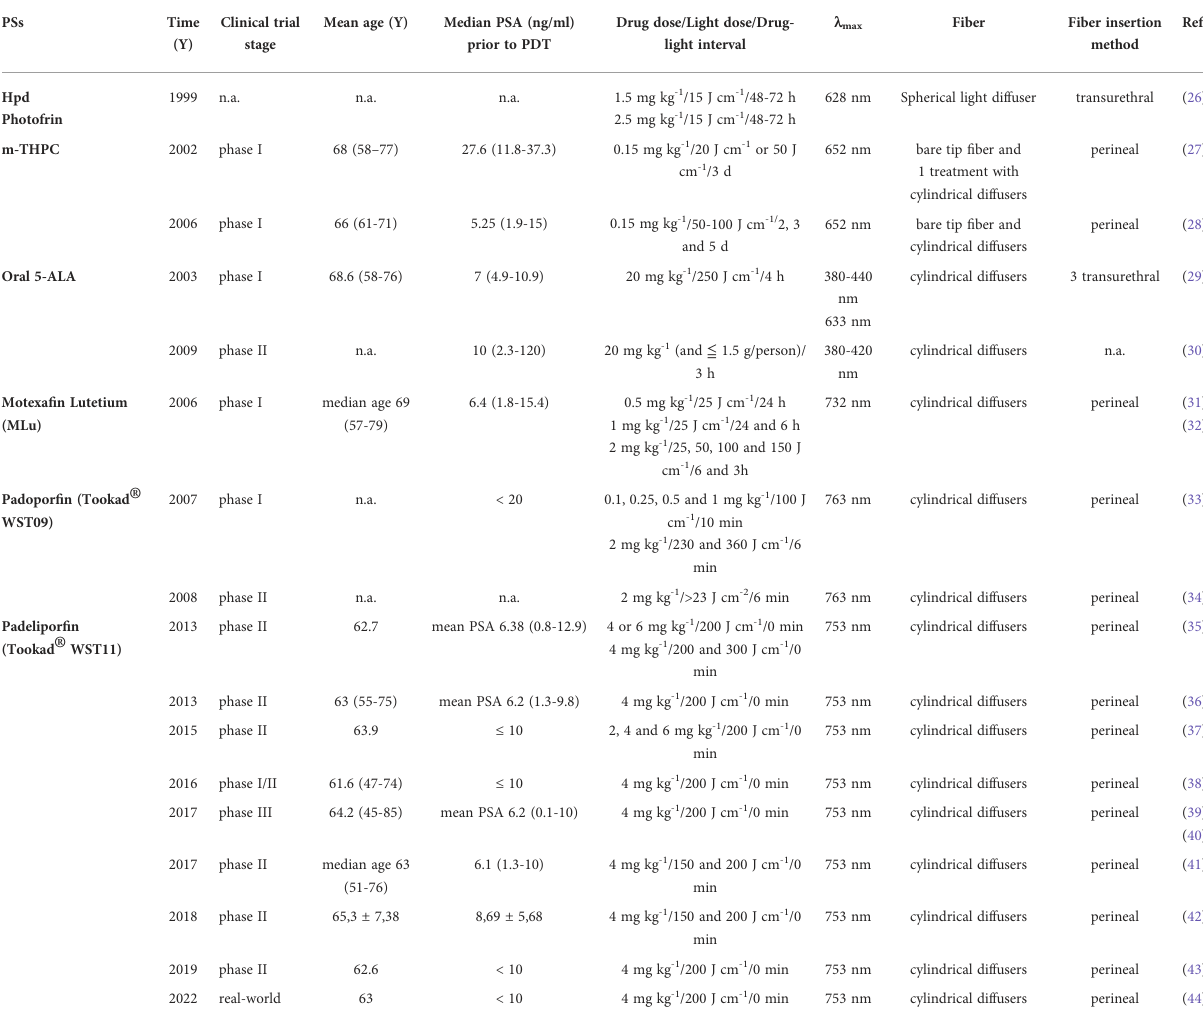
TABLE 3 Clinical trials of PDT for prostate